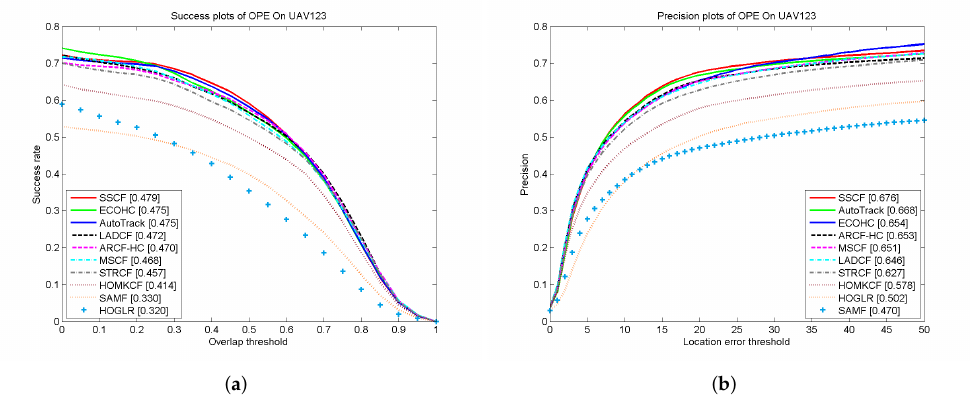
Figure 6. Success plots ( a ) and precision plots ( b ) of the proposed SSCF and the other trackers on the UAV123 database.